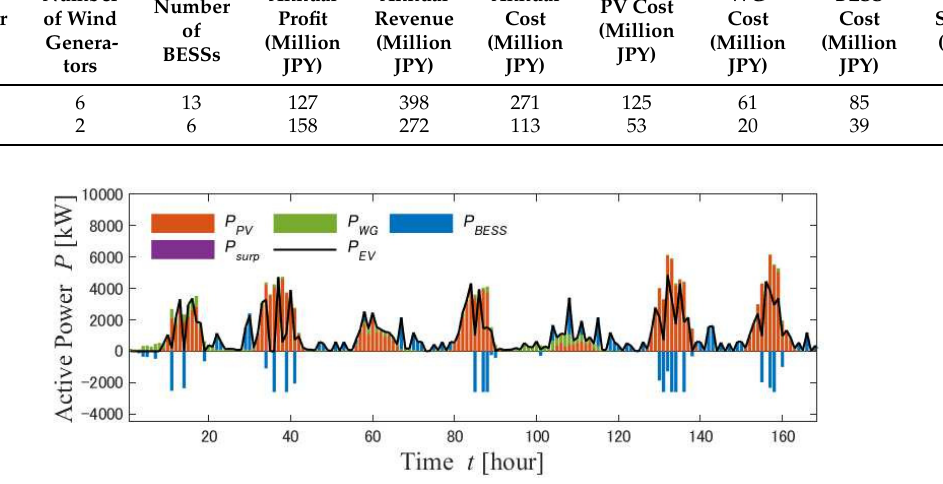
Figure 13. Generated power and load from April 1 to 7 (Case